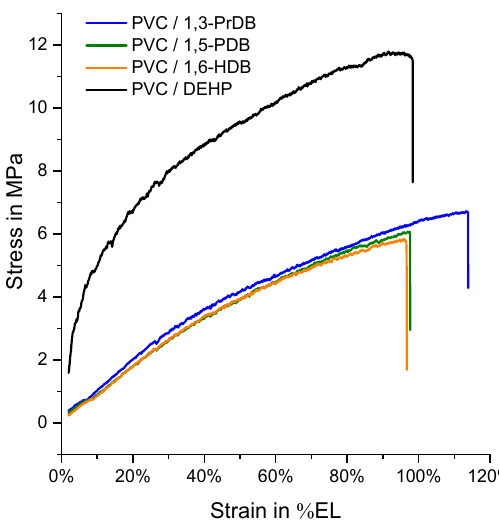
Figure 5. Examples of stress-strain curves of 40 phr blends of PVC with 1,3-PrDB, 1,5-PDB, 1,6-HDB, and DEHP. Results for 1,4-BDB are shown in Figure S1 and Table S2. Apparent moduli at 25% EL are listed in Table 2 and at 10% EL, 50% EL, and 75% EL in Table S1.